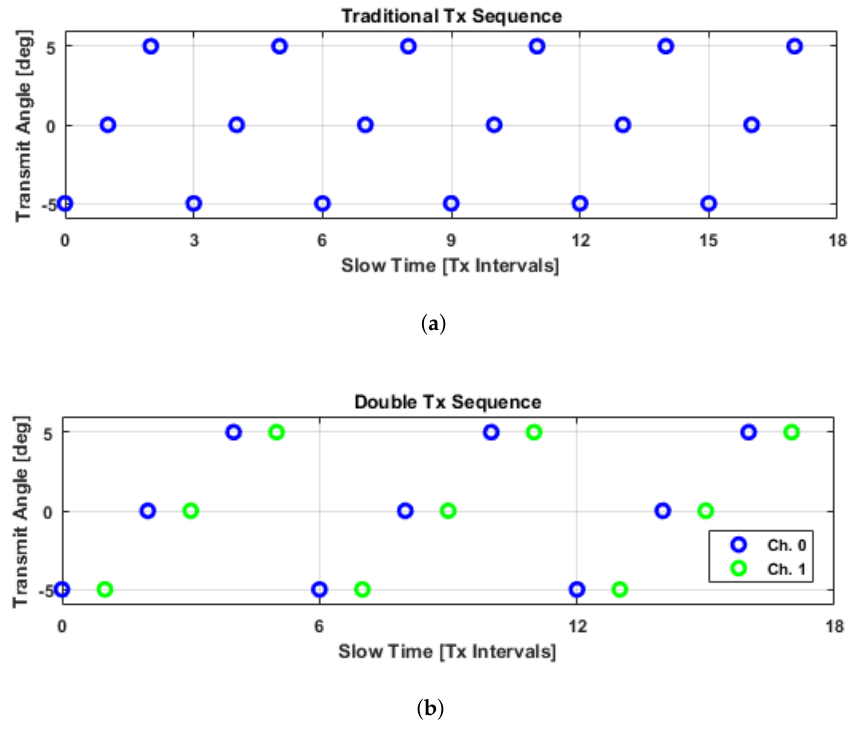
Figure 1. Comparison of the different transmit sequences used in this study. With the traditional transmit sequence, acquisitions with the same point spread function are spaced apart over intervals equivalent to a transmit sequence length. Due to the fact that these components will exhibit the strongest spatial correlations, reordering them such that they are temporally adjacent allows for correlation estimates at the shortest possible time interval. ( a ) Traditional transmit sequence where the transmit angles linearly increment and then repeat; ( b ) Double transmit sequence where the transmit angle repeats before linearly incrementing to the next